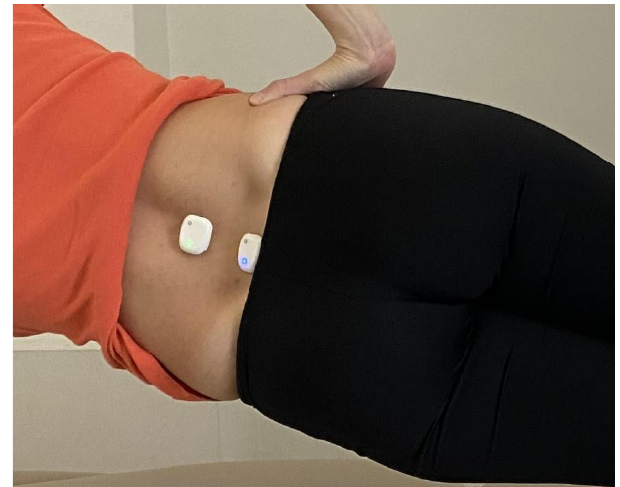
Figure 3. IMUs ’ placement on L1 and L5 vertebrae . Figure 3. IMUs’ placement on L1 and L5